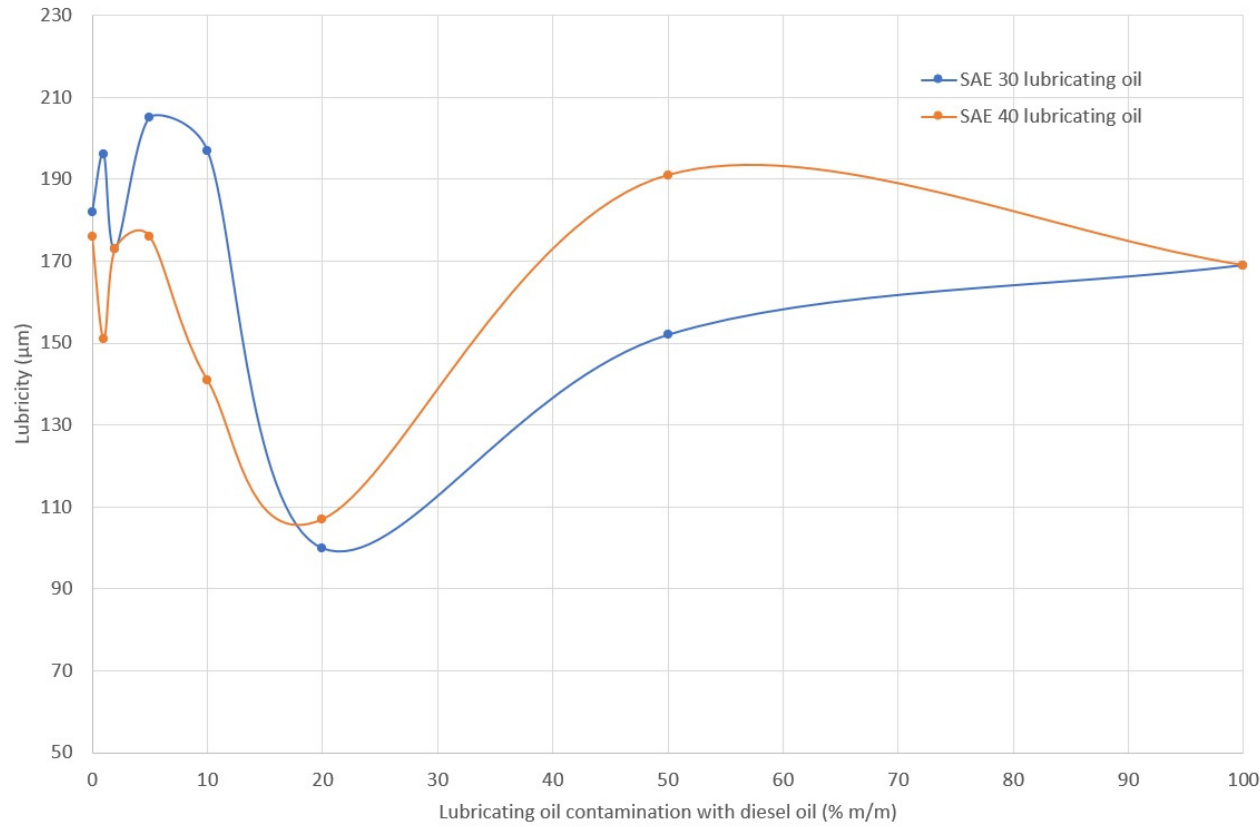
Figure 19. Lubricity of tested lubricating oils at different levels of lubricating oil dilution with diesel fuel. Lubricity values measured for pure oils are in the range of 180–190 µ m. The